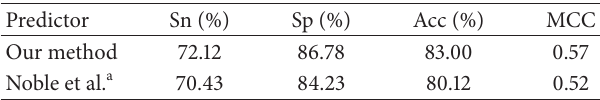
Table 1: Comparison of different methods for identifying DHS by the jackknife test on the same benchmark